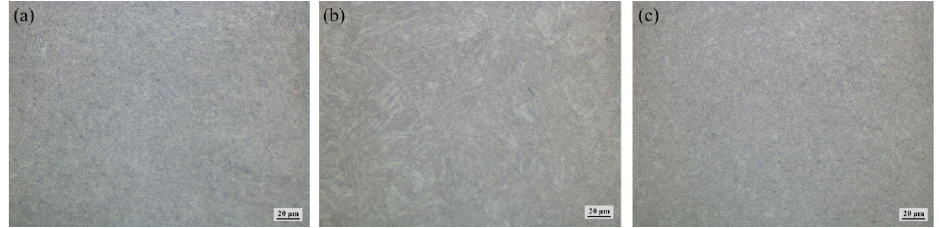
Figure 8. Microstructure of the welded joint of 155 mm-thick plates: ( a ) WZ; ( b ) CG-HAZ; ( c ) FG-HAZ.